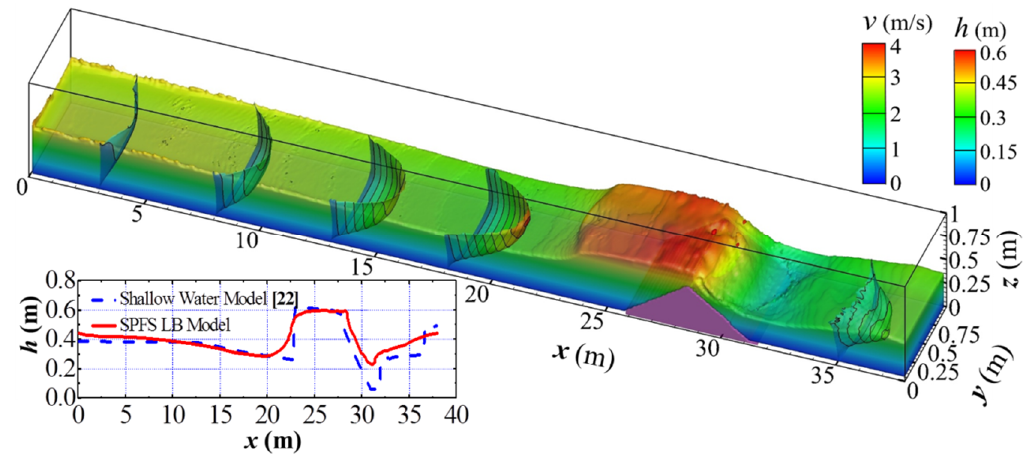
Figure 7. Water surface and velocity profile of dam-break flows at t = 9.7 s.